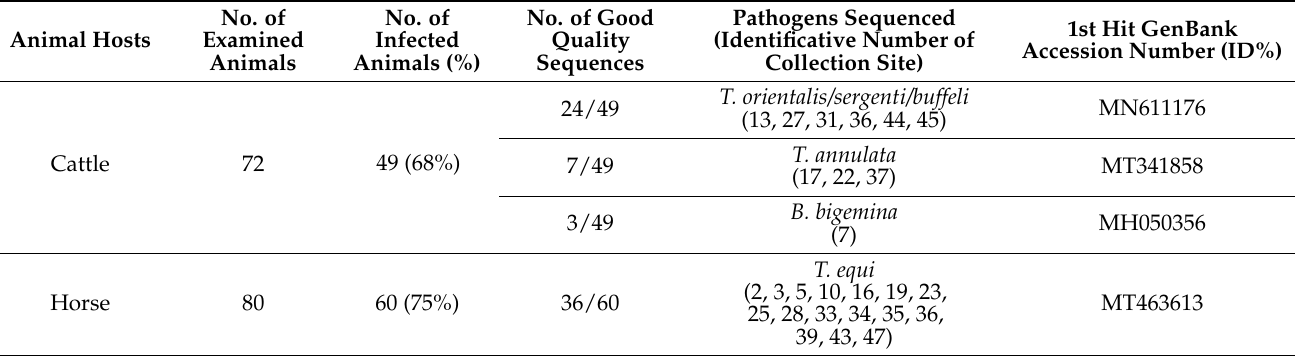
Table 1. Number of samples tested positive for Babesia and Theileria spp. and details of sequences obtained from horses and cattle in this